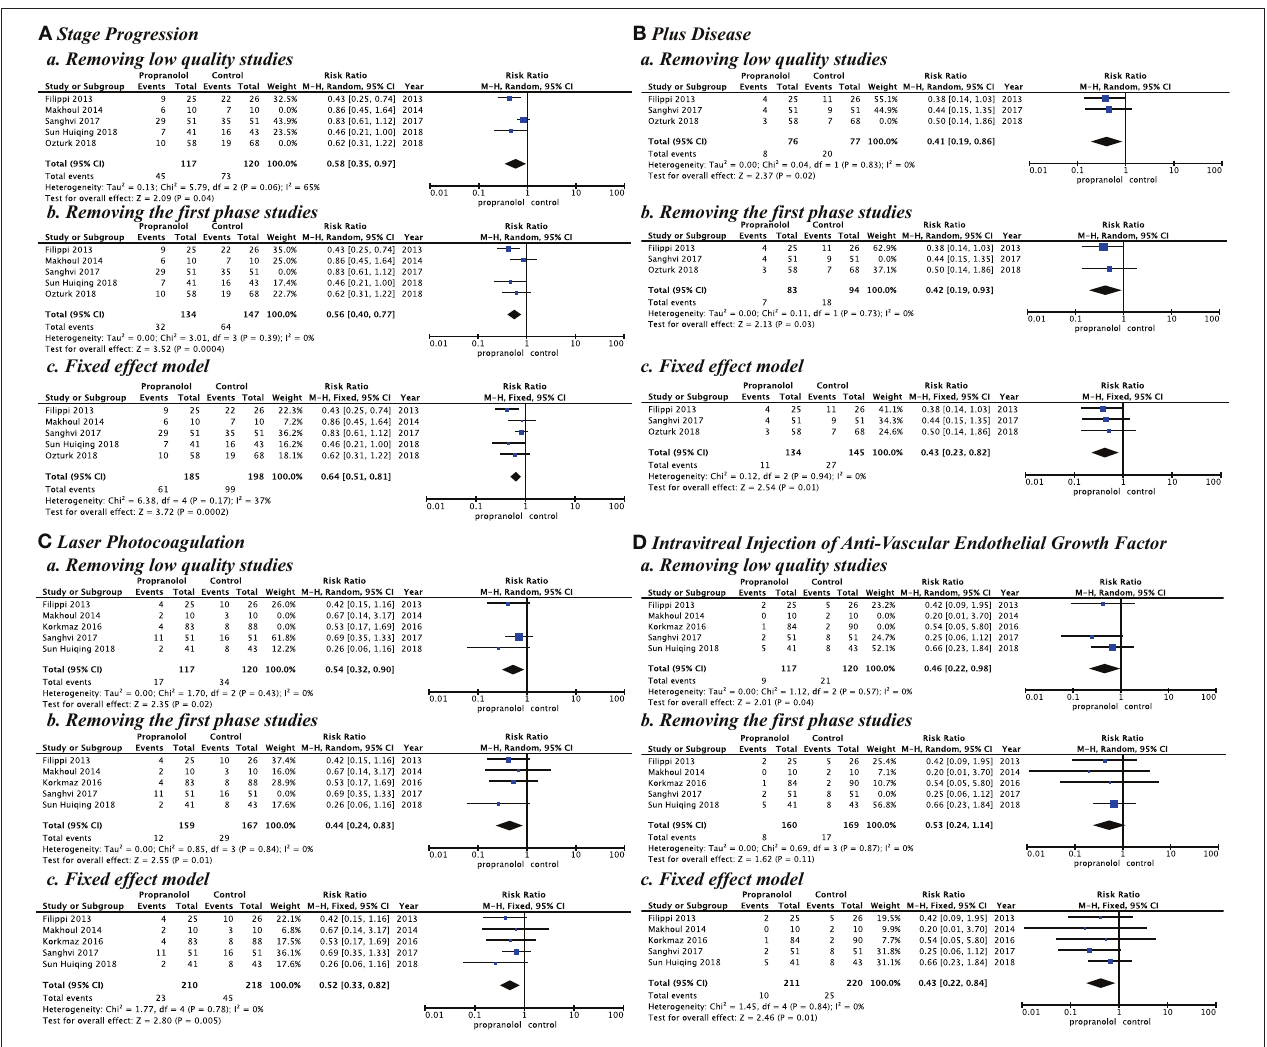
FIGURE 7 | Sensitivity analysis by research quality, inclusion criteria, and effect model. (A) Stage progression, (B) Plus disease, (C) Laser photocoagulation, and (D) Intravitreal injection of anti-vascular endothelial growth